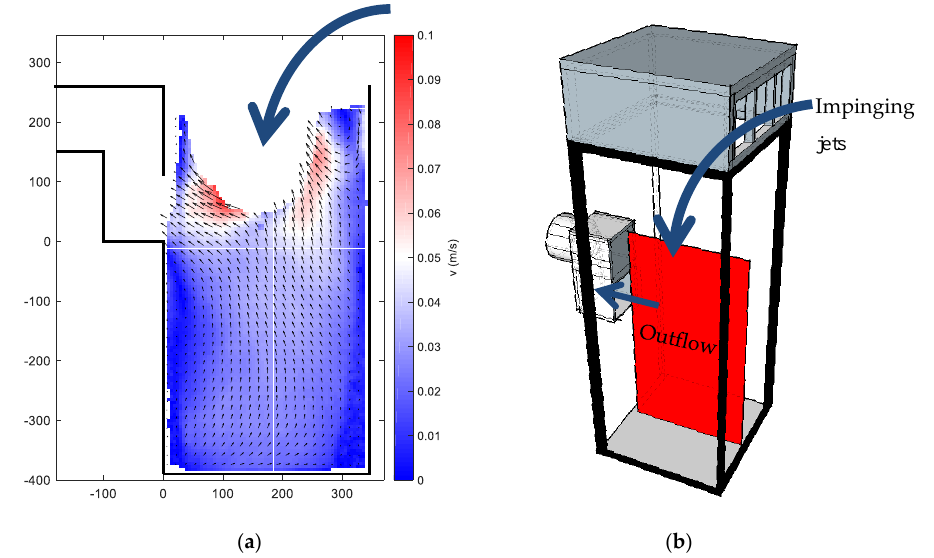
Figure 9. ( a ) Streamlines and mean velocity for the test with sand trap depth of 0.39 m, outlet at the back, and discharge 1.0 L/s. The white area in the upper part of the figure represents an area with a high fraction of air bubbles (entrained by the impinging waterjet) which disturbed the PIV measurements; ( b ) The POI and gully pot layout of the test.